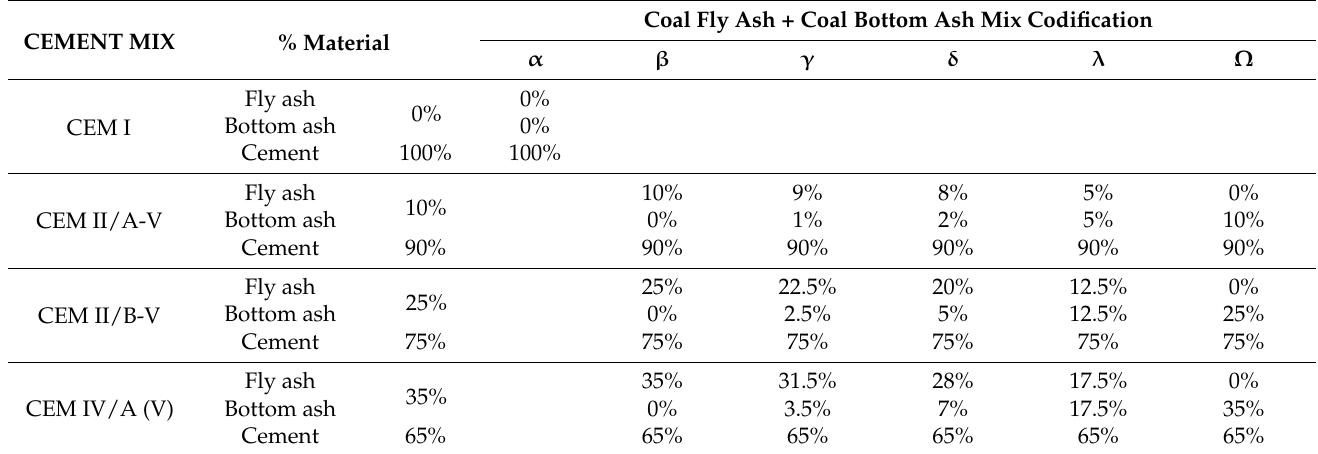
Table 2. Bottom ash (BA) with fly ash (FA) and cement (CEM I 42.5 N) mixes.